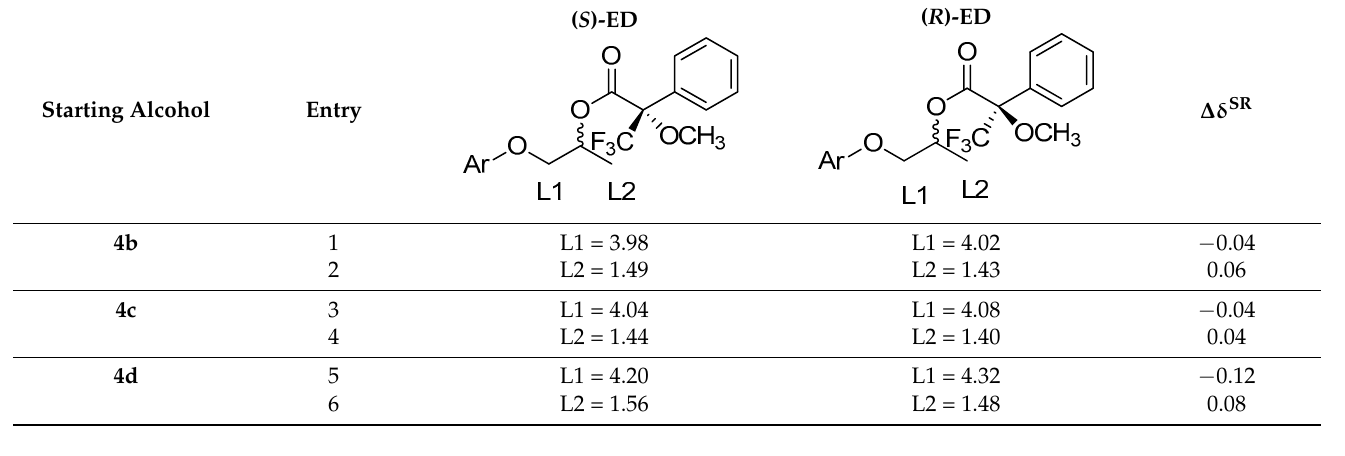
Table 5. Values of chemical shifts ( δ ) of L1 and L2 in esters ( S )-ED and ( R )-ED and the corresponding values of ∆ δ SR .